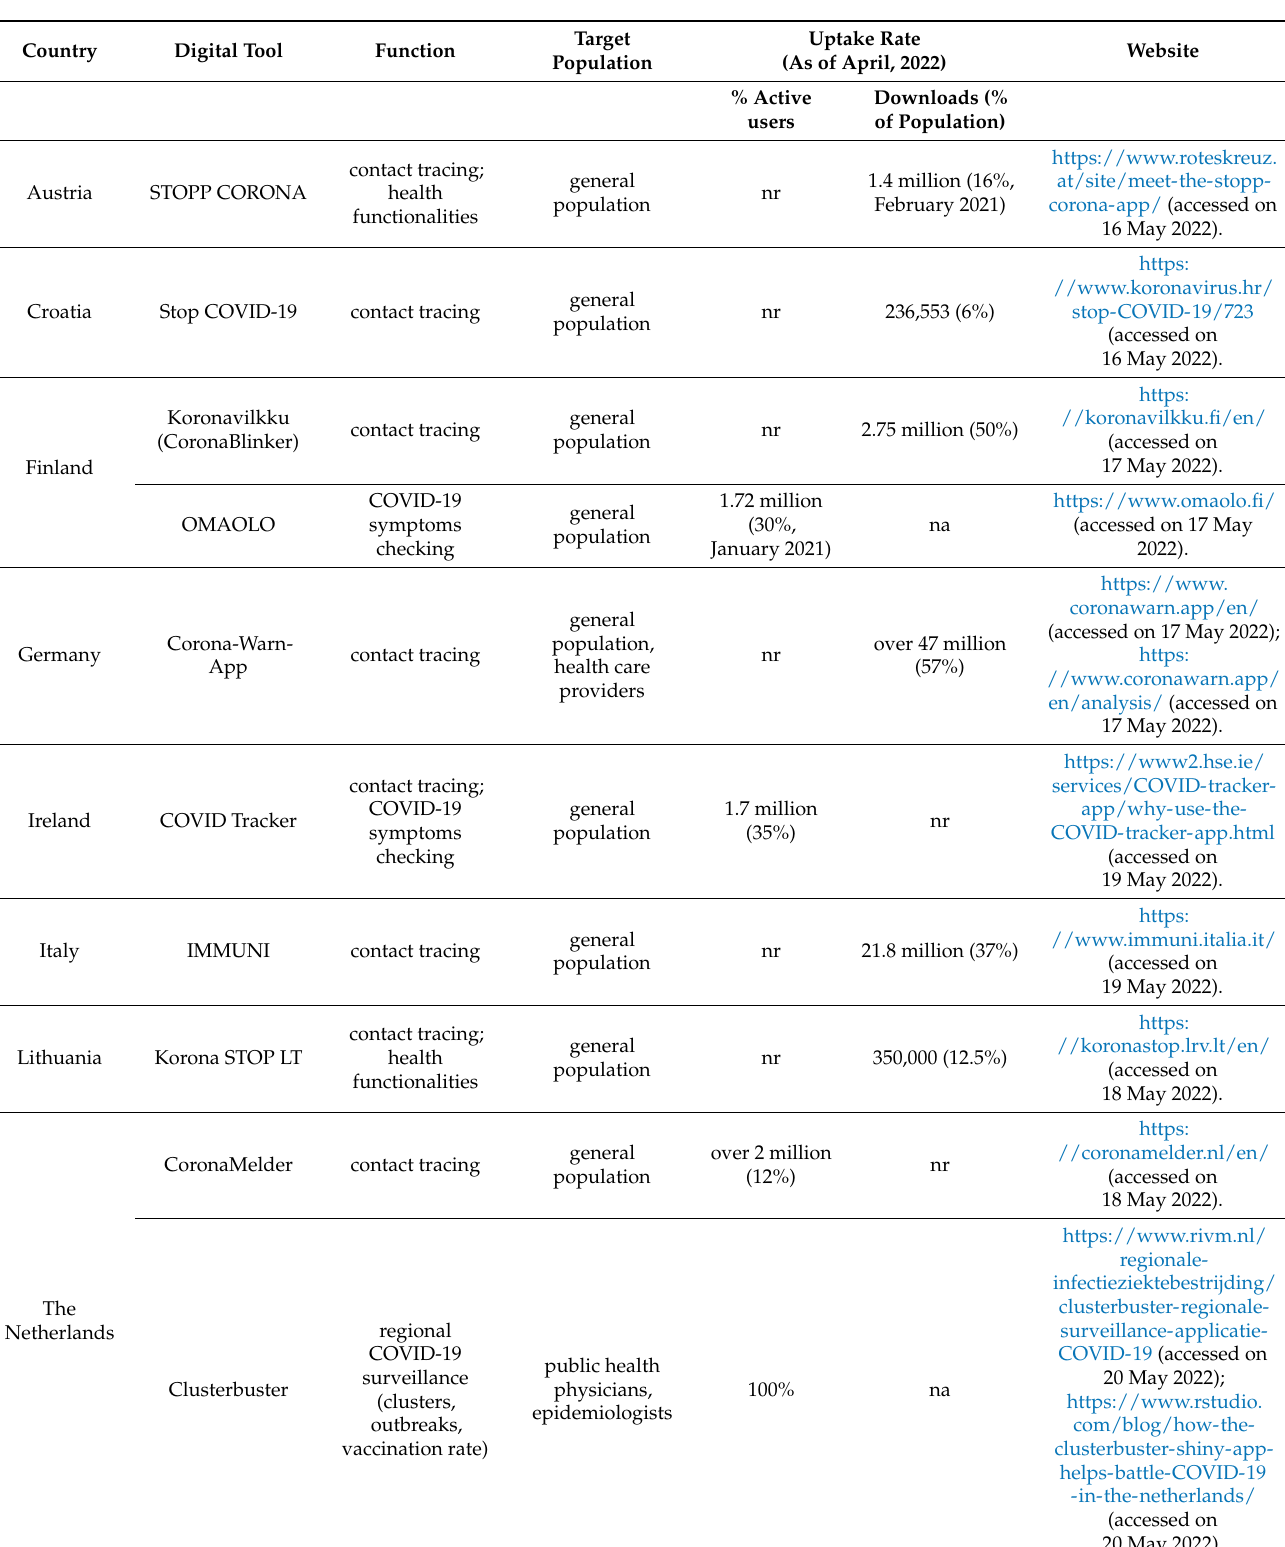
Table 1. General characteristics of digital tools used for COVID-19 monitoring in